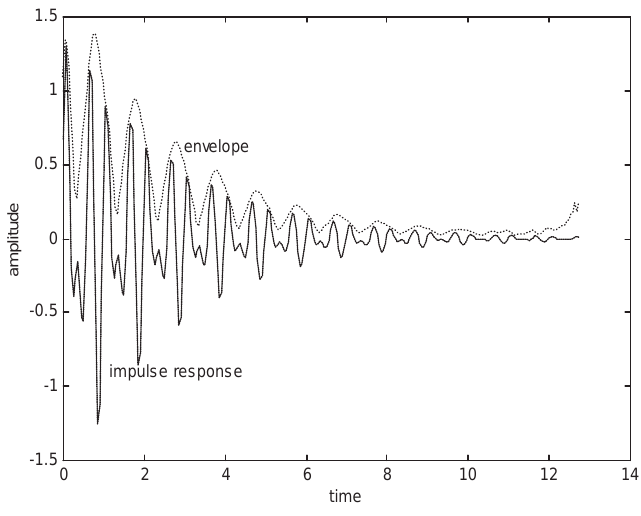
Fig. 3. Envelope Calculated for an Impulse